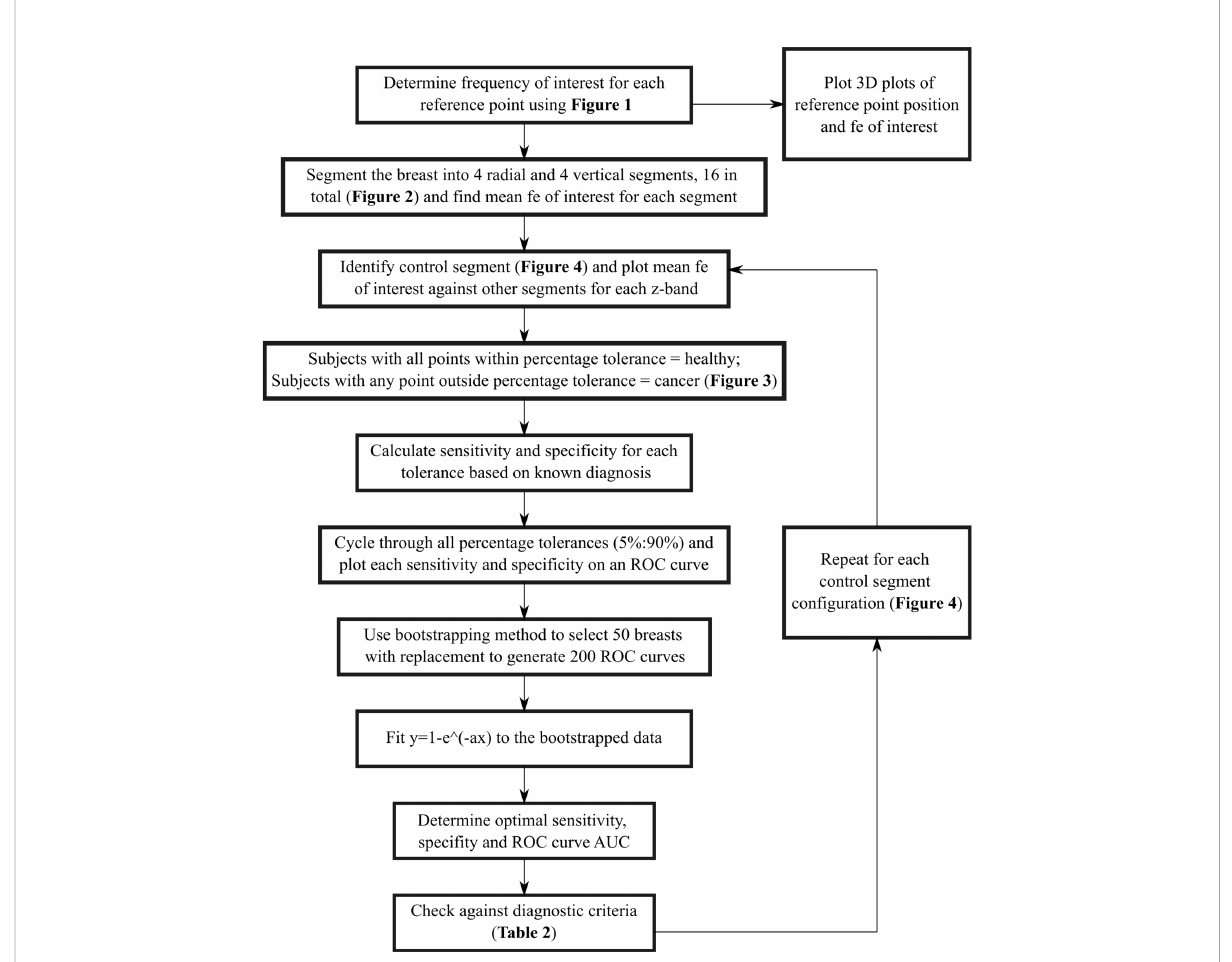
FIGURE 4 Flowchart showing full method to obtain